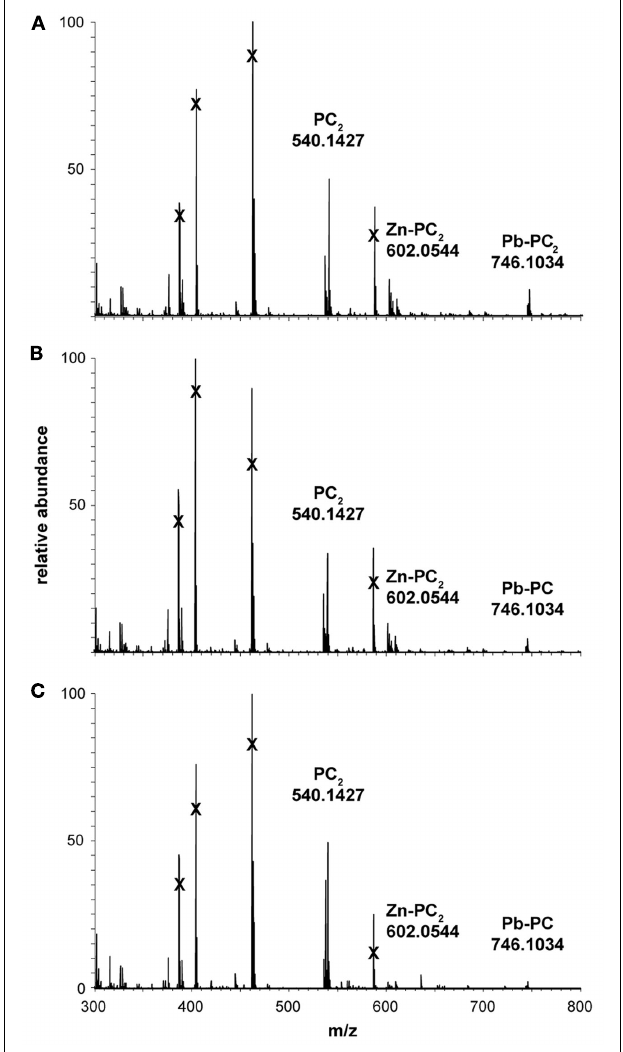
FIGURE 8 | Nano-ESI-MS full-scan spectrum of competition experiments between Pb and Zn with increasing Zn concentrations from (A–C). The concentrations are (A) 0.125mM Zn, (B) 0.25mM Zn, and (C) 0.5mM Zn. X = matrix ions.